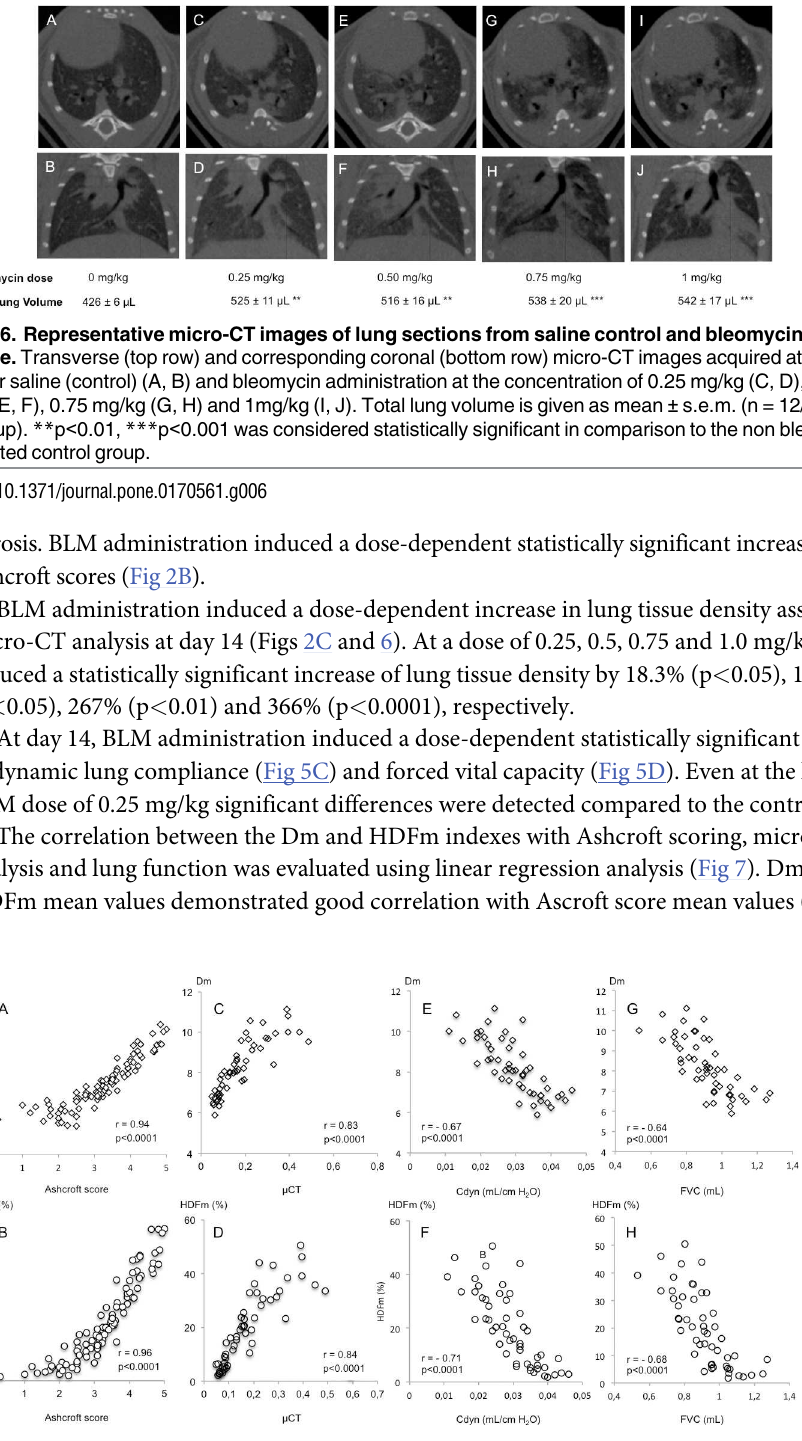
Fig 7. Correlation of tissue density (Dm) and high frequency density (HDFm) indexes with Ashcroft score, micro-CT and lung function measurements in the bleomycin mice model. The agreementof the Dm and HDFm measurements with those obtained with Ashcroft scoring(A, B), micro-CT analysis(C, D), dynamic lungcompliance(Cdyn) (E, F) and force vital capacity (FVC) (G, H) was evaluatedusing linear regression analysis. Data correspondto mean values per animal of salinecontrol (n = 6) and BLM-treated (0.25, 0.50, 0.75, 1 mg/kg) (n = 12/dosinggroup) mice. r = Spearman